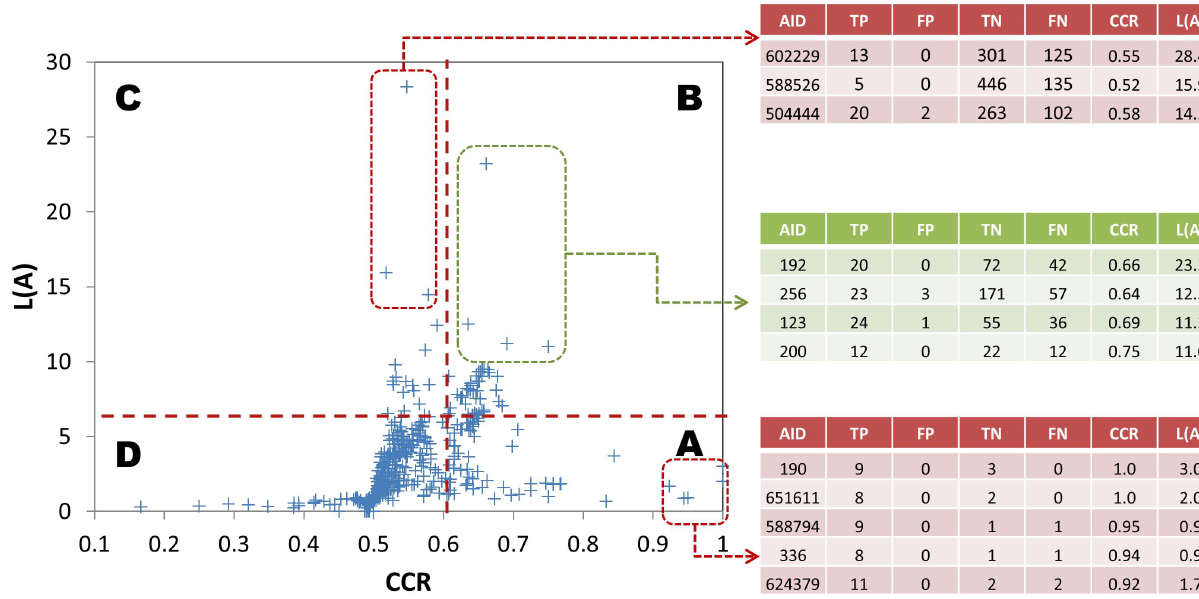
Figure 3. The distributions of 555 bioassays against their CCR values and the L parameters with animal acute toxicity. The graph could be divided into 4 areas by using two cutoff values (CCR=0.6 and L =7): 1) A indicates low L and high CCR; 2) B indicates high L and high CCR; 3) C indicates high L and low CCR; and 4) D indicates low L and low CCR. The tables on the right side displayed the counts of TP, FP, TN, FN along with CCR and L values for some bioassays from area A, B and C, respectively.